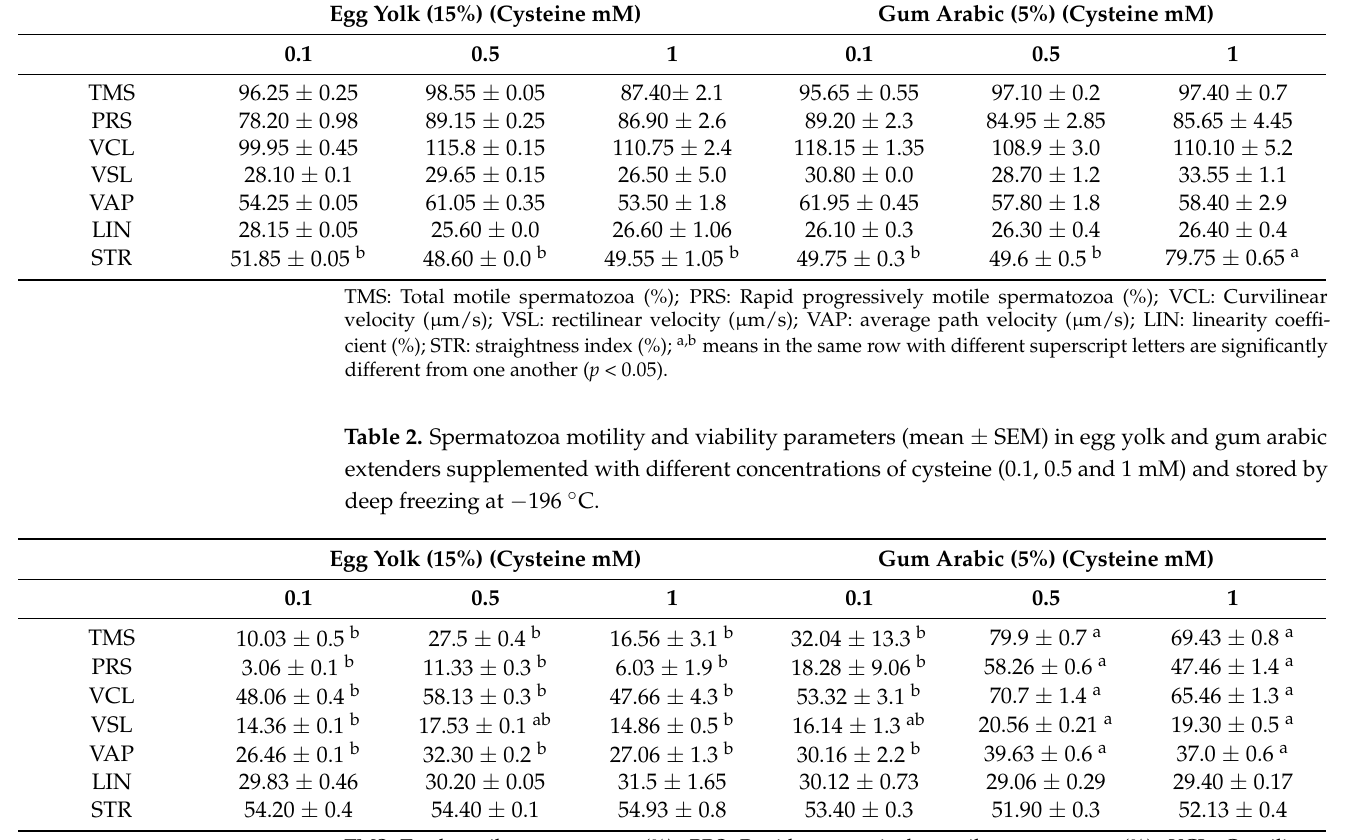
Table 1. Spermatozoa motility and viability parameters (mean ± SEM) in egg yolk and gum arabic extenders supplemented with different concentrations of cysteine (0.1, 0.5 and 1 mM) after cooling. Egg Yolk (15%) (Cysteine mM)